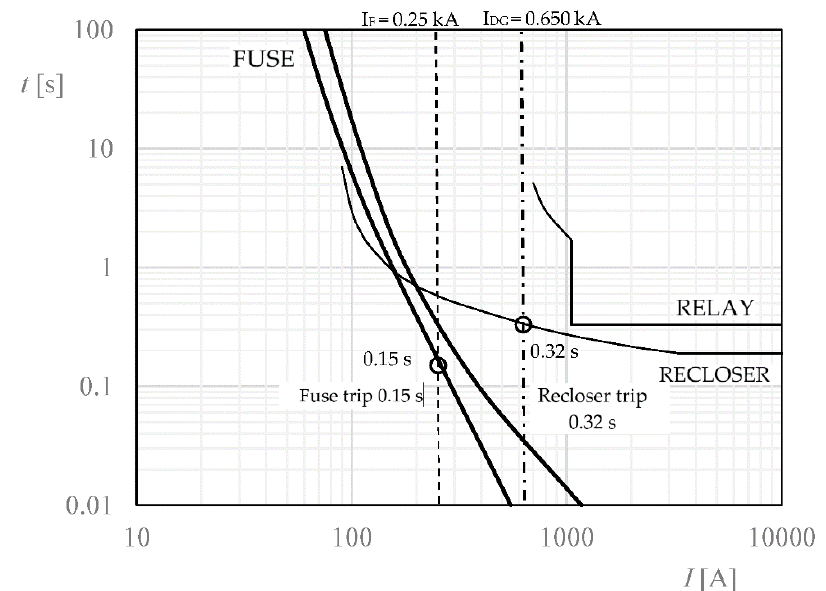
Figure 7. Failure coordination between recloser, RC, and fuse, F, see also Figure 6.